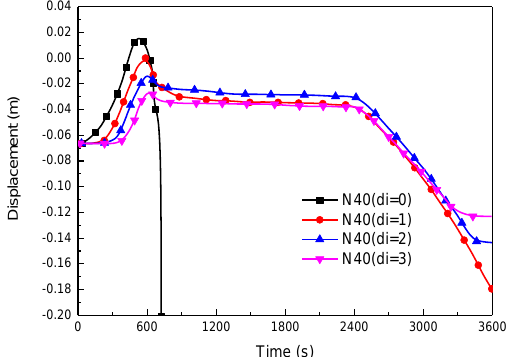
Figure 26. Time-history curve of vertical displacement (influence of fireproof coating).